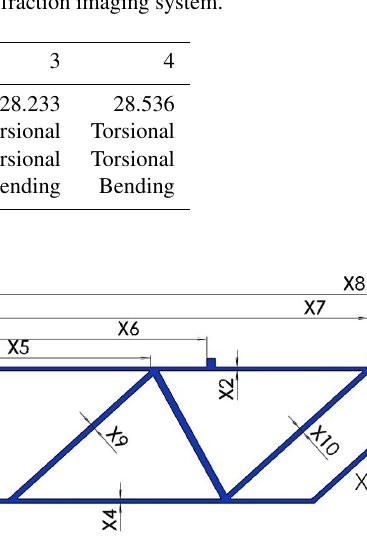
Figure 12. Schematic of the design variables of the truss support structure.